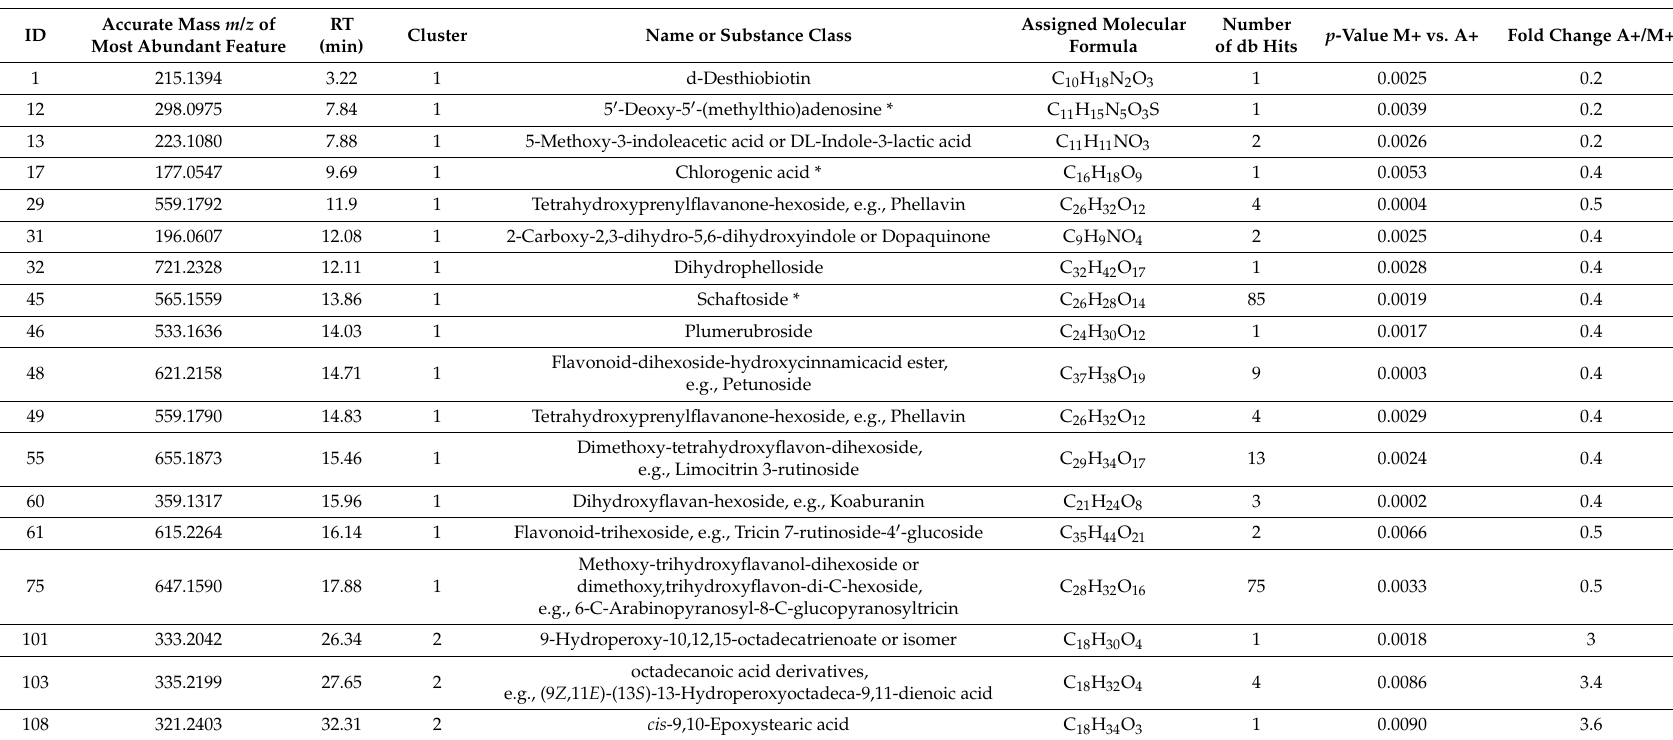
Table 2. Metabolites significantly differing between A+- and M+-derived wheat ear samples and that were annotated by matching accurate m / z and number of carbon